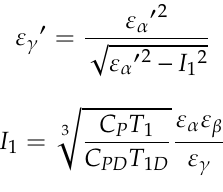
Figure 16. Results comparison of test and FEM of contact pattern: ( a ) Load T = 500 Nm, ( b ) Load T = 1500 Nm, and ( c ) Load T = 4500 Nm.